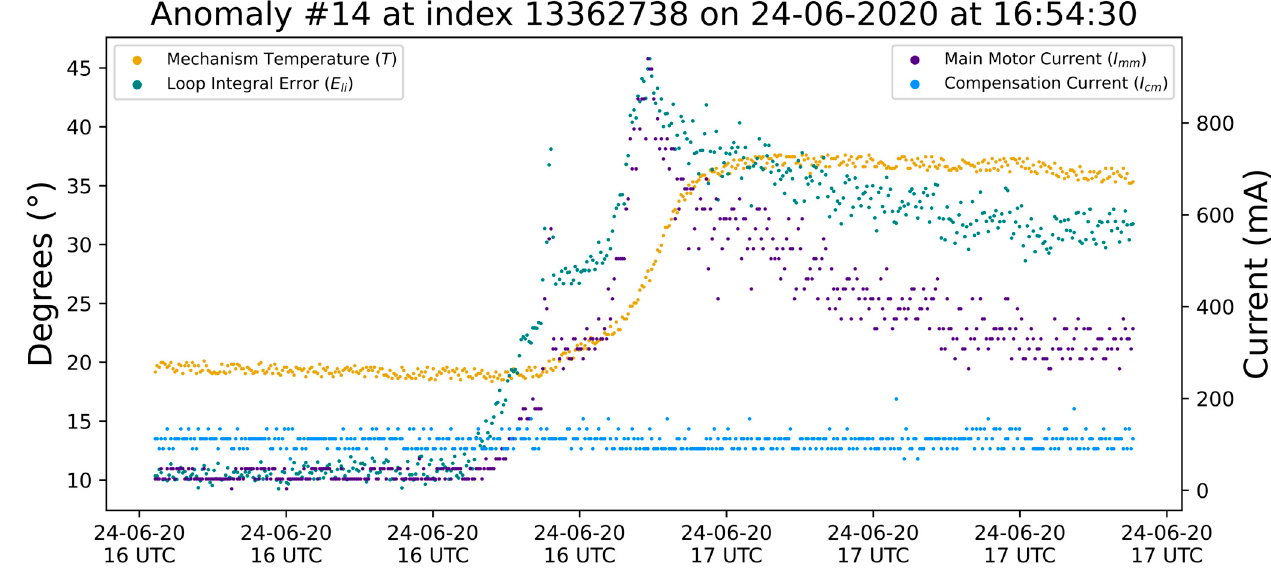
Figure 5. Time series of ATMS main motor current ( I mm ), compensator motor current ( I cm ), loop integral error ( E li ), and mechanism temperature ( T ) during one of the cases included in this study.